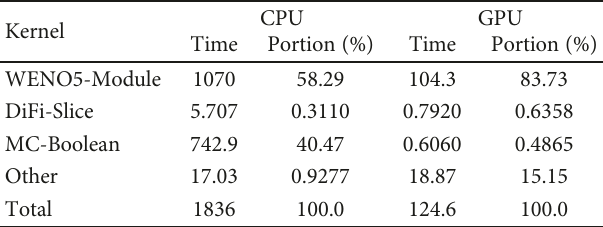
Table 6: Comparison between CPU and GPU execution times (per simulation): CPU: Intel i54570; GPU: NVIDIA